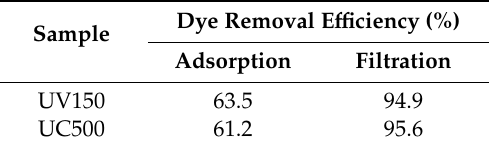
Table 8. Results from the adsorption coupled with filtration